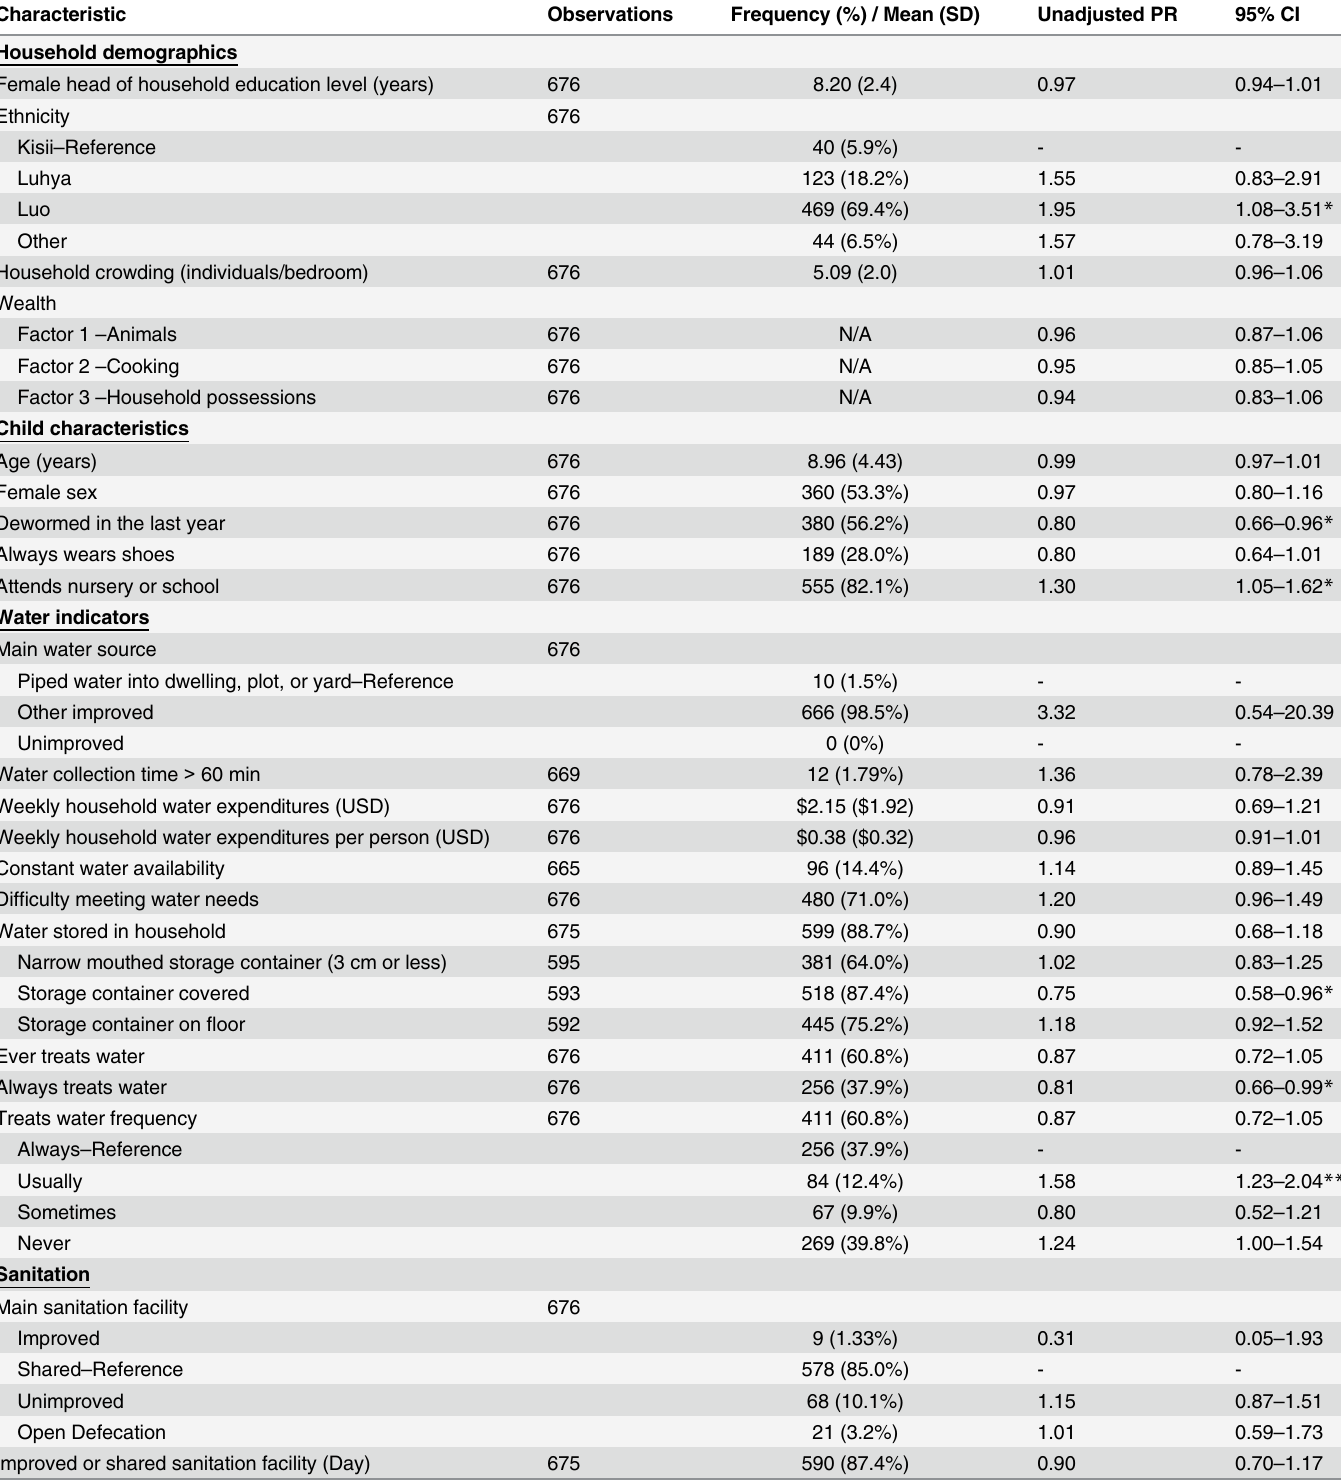
Table 1. Bivariate Associations for Selected Water, Sanitation, and Hygiene-related Risk Factors with Any Soil-Transmitted Helminth Infection among PSAC and SAC Children.